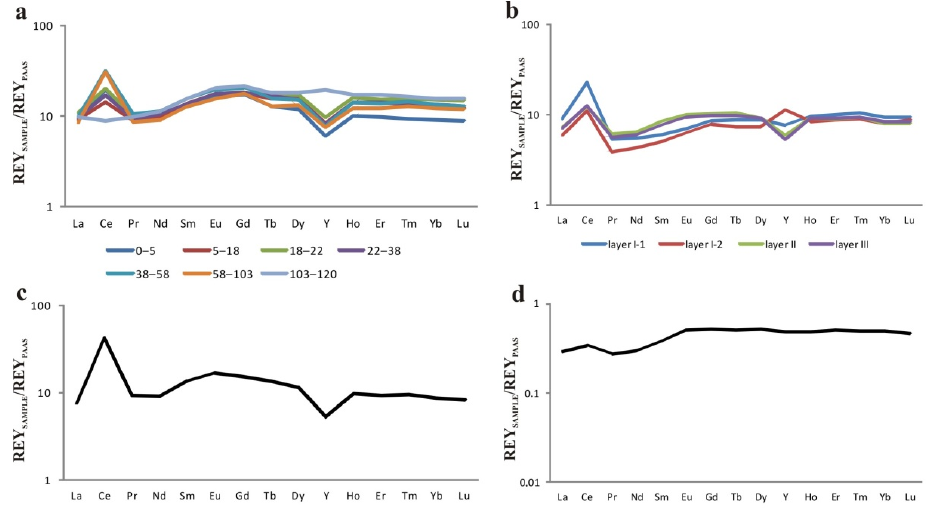
Figure 4. Shale-normalized (PAAS) compositions of REY of ferromanganese crusts. ( a ) Detroit guyot; ( b ) Zubov guyot; ( c ) Gummi Bear seamount; ( d ) Belyaevsky underwater volcano.